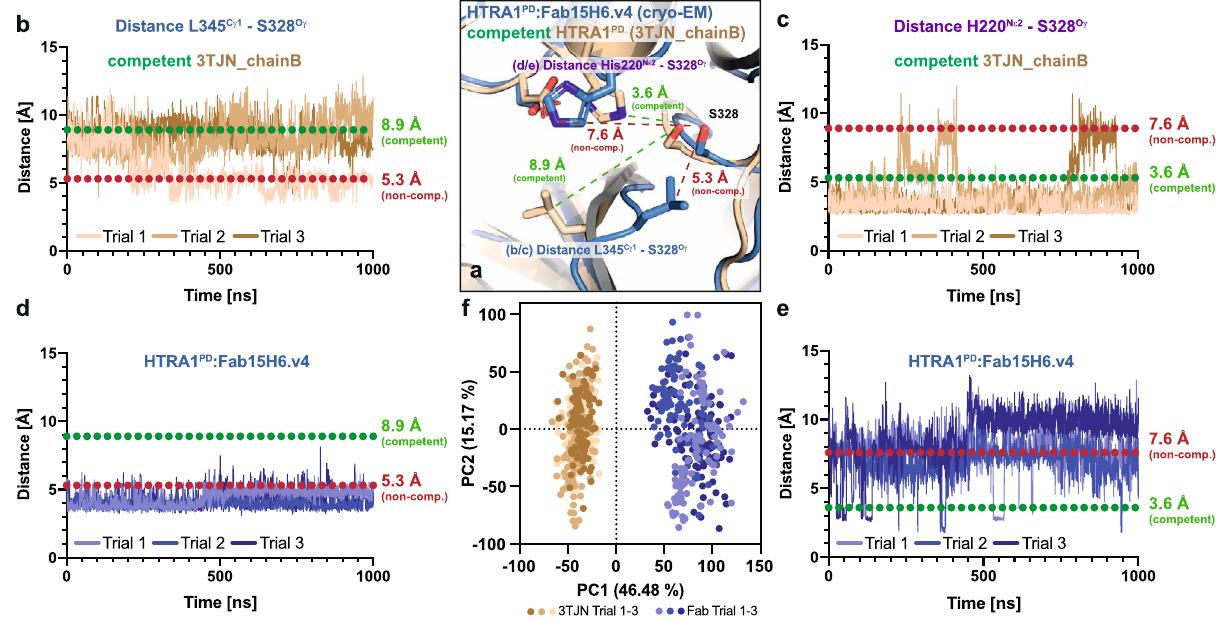
Fig.3|Moleculardynamics(MD)simulationsshowthatbindingofFab15H6.v4 to LoopA locks HTRA1 in a non-competent state. a Detailed conformational differenceswithinthecatalyticcenterofcompetent(brown,pdb3TJN_chainB)and Fab-bound HTRA1 PD (blue). The distance (dashed line) between L345 and S328 decreases from competent (green) to the non-competent conformation (red) whereitoccludestheS1pocket.Thedistance(dashedline)betweenH220andS328 increases when transitioning from the active (green) to the inactive (red) con- formation,impedingthehydrogentransferduringcatalysis. b , c Measureddistance between L345 C γ 1 and S328 O γ ( b ) and between H220 N ε 2 and S328 O γ ( c ) during the MD